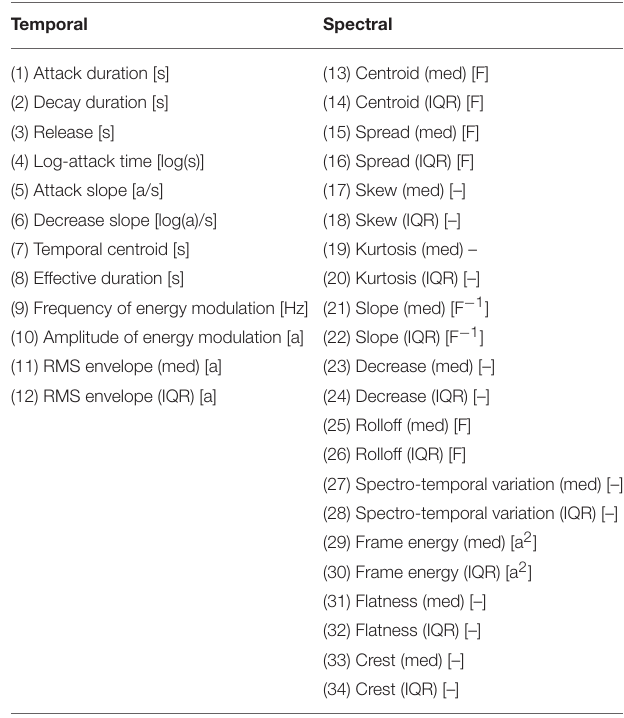
TABLE 2 | List of acoustic descriptors from the TimbreToolbox (Peeters et al., 2011).